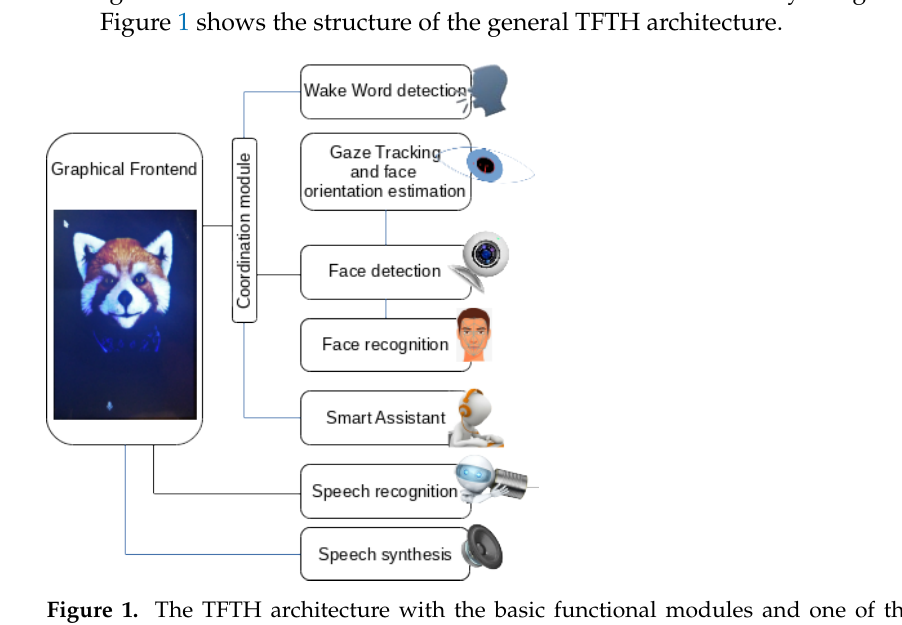
Figure 1. The TFTH architecture with the basic functional modules and one of the supported graphical